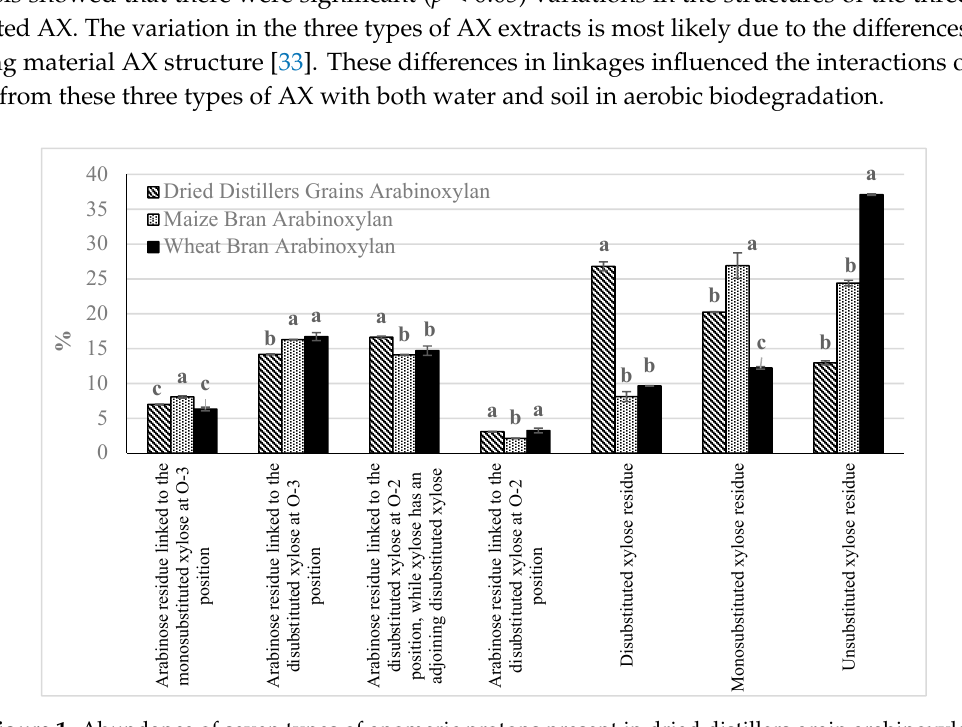
Figure 1. Abundance of seven types of anomeric protons present in dried distillers grain arabinoxylan, maize bran arabinoxylan, and wheat bran arabinoxylan as determined by 1 H Nuclear Magnetic Resonance Spectrometry. Columns with the same letter for the same proton are not significantly ( p < 0.05) di ff erent, error bars represent standard